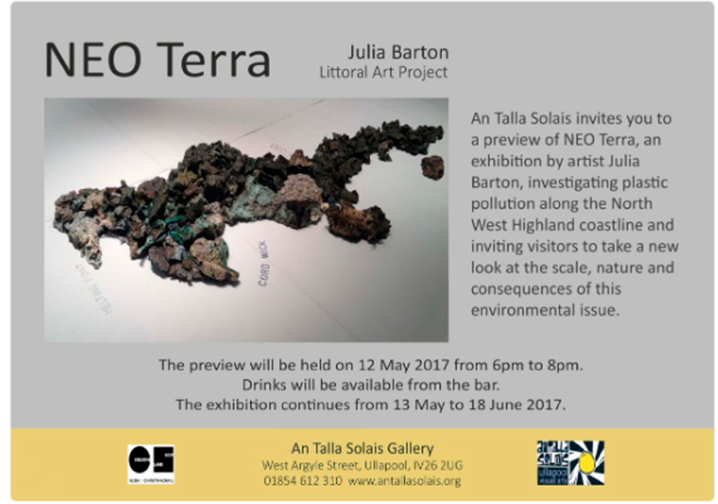
Figure 1. Neo Terra exhibition invite. An Talla Solais, Ullapool. 13 May–18 June 2017. Photograph created by the author.